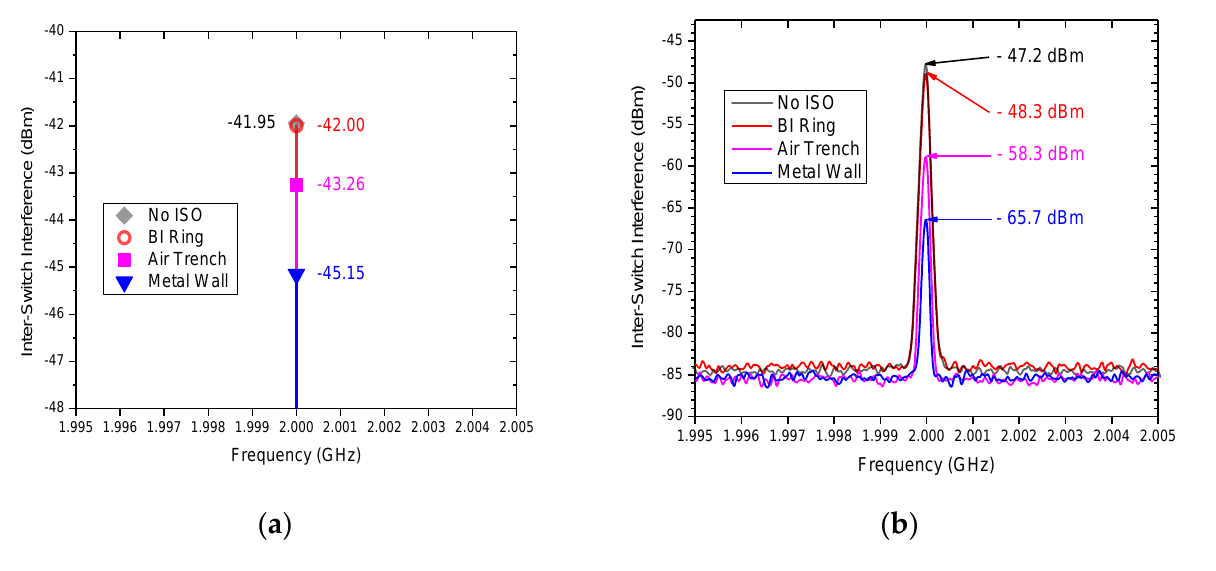
Figure 14. Crosstalk comparison of SPDT splits: ( a ) HFSS-ADS cosimulation, and ( b ) measurement (0 dBm input to Switch A; interference measured at output of Switch B) [35].